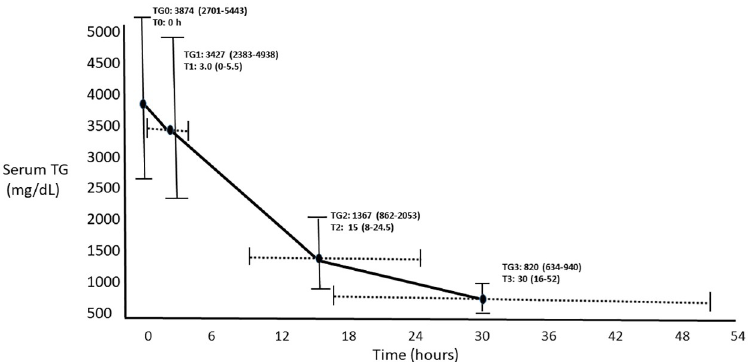
Fig 2. Reduction in serum triglyceride levels over time after insulin initiation in the 73 responders. TG0 and T0-Intial TG and time, TG1 and T1-TG and time as insulin initiation, TG2 and T2-TG and time for reduction by 50% or less, TG3 and T3-TG goal and time at insulin drip